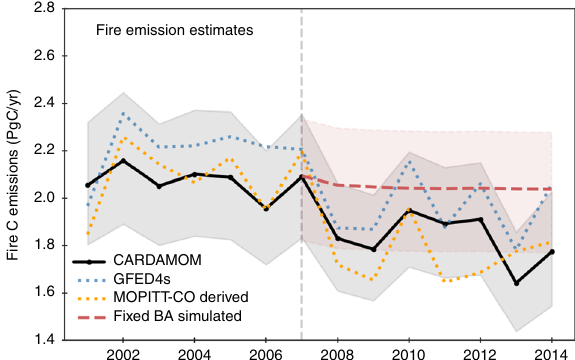
Fig. 2 Global fi re carbon emissions estimates for 2001 – 2014. The solid black line represents fi re carbon emissions estimated by the ensemble median of CARDAMOM, and the shading describes the fi rst and third quartiles using a Monte-Carlo sampling of the parameters. The dotted blue line shows GFED4s bottom-up estimates, and the dotted orange line shows the estimates derived from MOPITT CO inversion and biome-speci fi c emission ratios between CO and total carbon. The dashed red line represents simulated fi re emissions using the average burned area during 2001 – 2007.